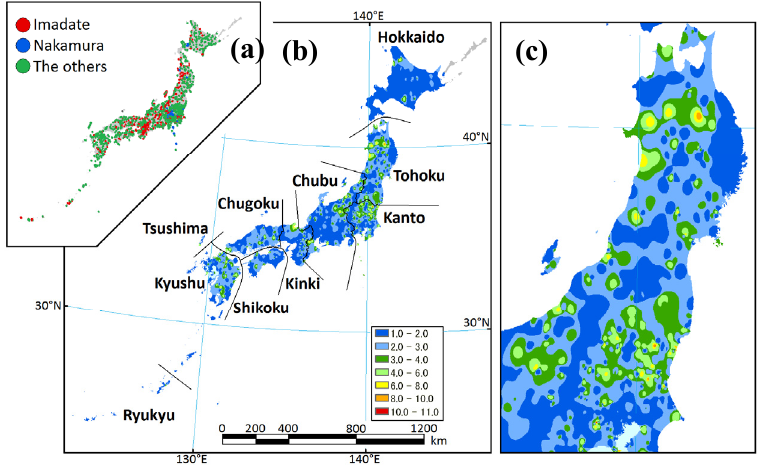
Figure 1. ( a ) Sections of the Protura record reported by Imadaté (red), Nakamura (blue), and others (green); ( b ) Species density distribution was estimated using the inverse distance weighted (IDW) interpolation method of ArcGIS; ( c ) Species distribution in the northern part of Honshu (Main Island composed of Tohoku, Kanto, Chubu, Kinki, and Chugoku) (enlarged). Color indicates estimated species richness in each locality in (panels b,c).